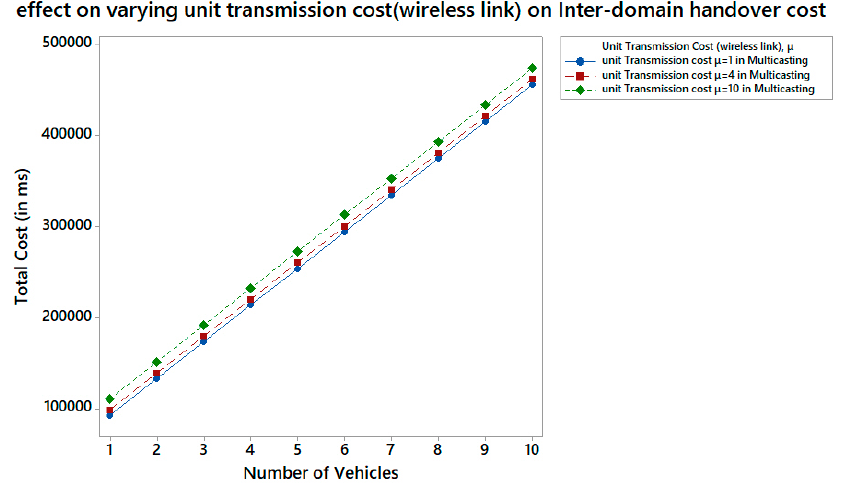
Figure 10. Effect of varying unit transmission cost (wired link) on inter-domain handoff.